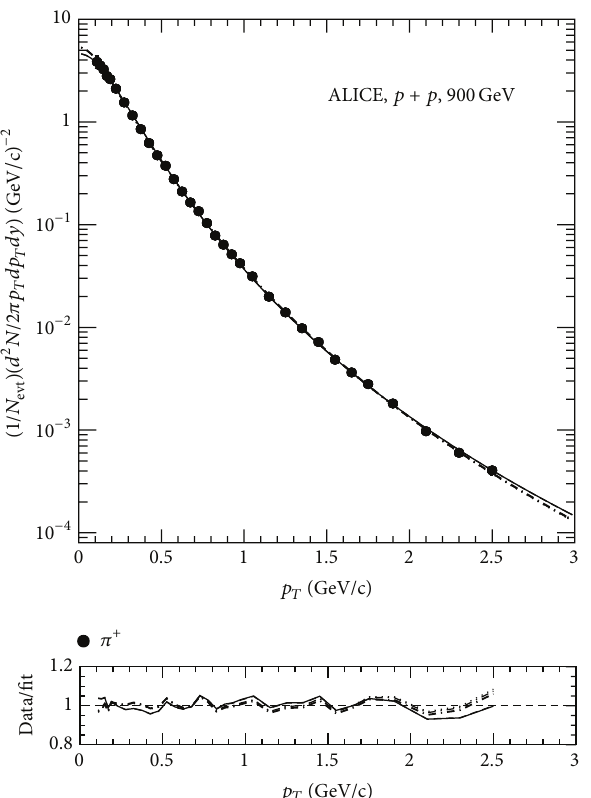
Figure 2: Same as in Figure 1 for 𝜋 + in 𝑝 + 𝑝 collisions at √𝑠 = 900 GeV. Data are taken from ALICE [27].